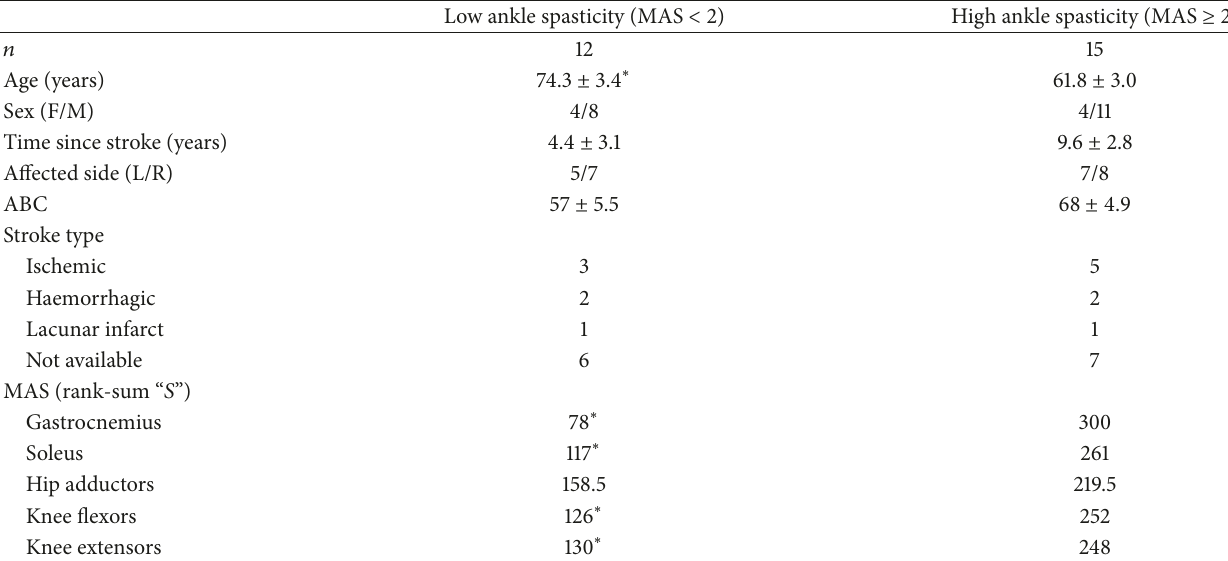
Table 1: Participants’ characteristics table.